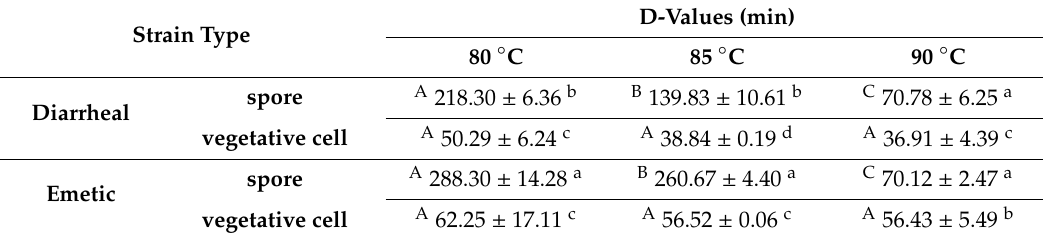
Table 3. D-values of diarrheal and emetic B. cereus strain in